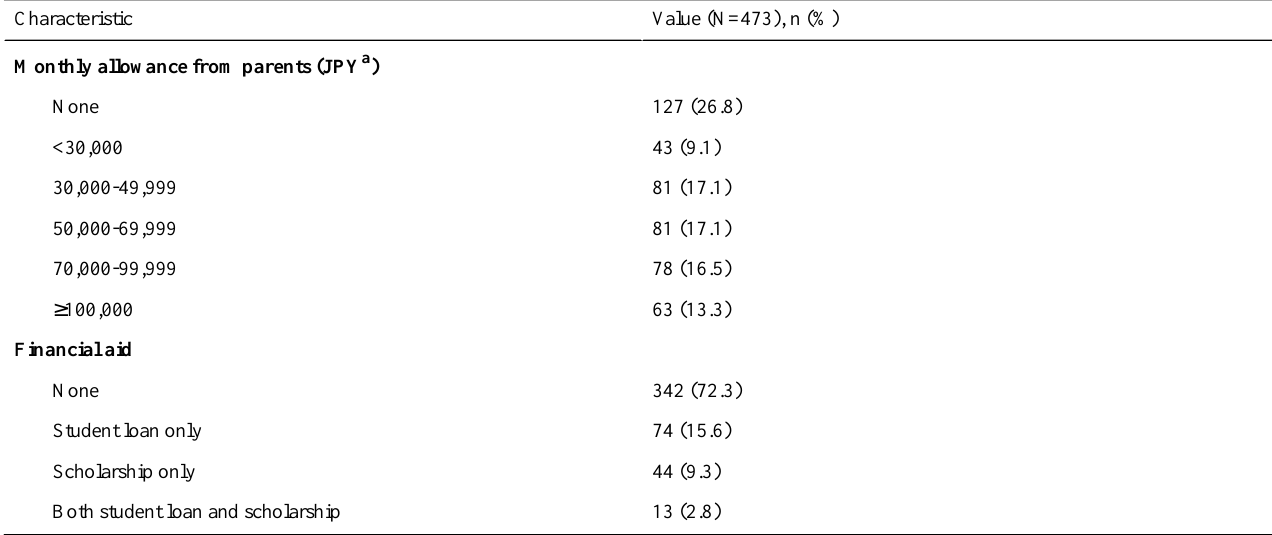
Table 5. Description of the financial situation of Japanese medical